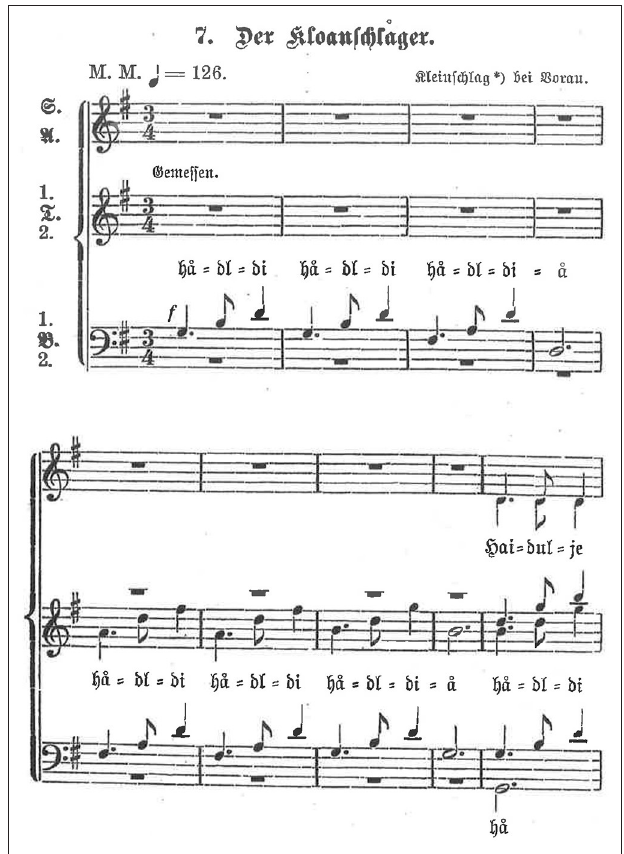
FIGURE 1 | An example of a yodeler from our sample shows that dotted and half notes tend to be linked with syllables containing the vowel å / O / that has a longer intrinsic duration.